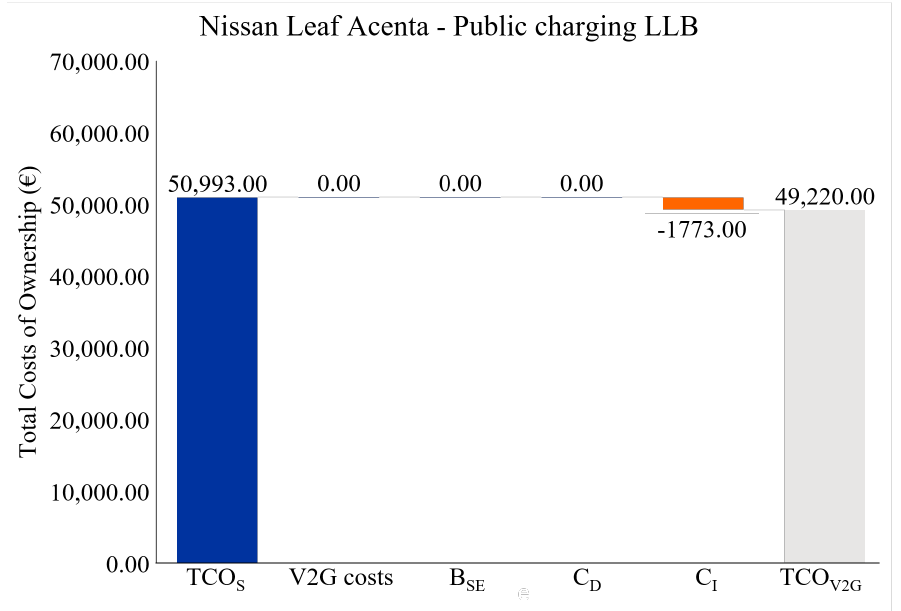
Figure 11. Standard and V2G TCO of a Nissan Leaf in a public charging case providing LLB ( TCO S = Standard TCO, B SE = benefit of saved electricity costs from the grid, C D = direct compensa- tion, C I = indirect compensation, TCO V 2 G = V2G TCO); source: own